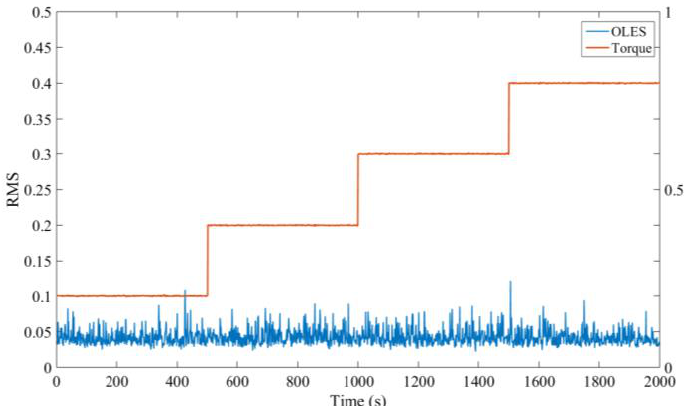
Figure 16. The variation of the electrostatic signal with torque.